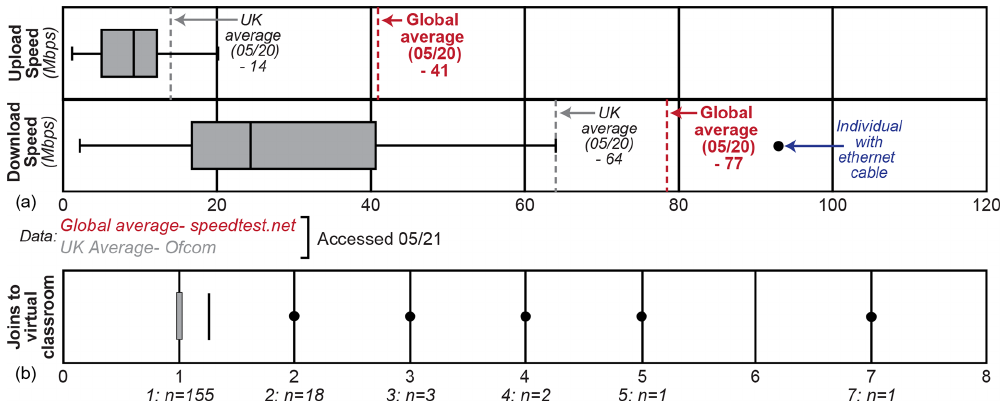
Figure 1. Internet speed and connectivity data. (a) Student internet upload and download speeds, presented in megabits per second (Mbps) and plotted as full and interquartile ranges with the averages marked. The student cohort data are compared to UK and global averages for the same time period as the virtual field trip (May 2020). Note that the one student with an ethernet cable plots as an outlier with respect to download speeds. (b) Data from the online student classroom that summarize the number of joins per session to the virtual classroom to 22 live online sessions over the 5-week virtual field